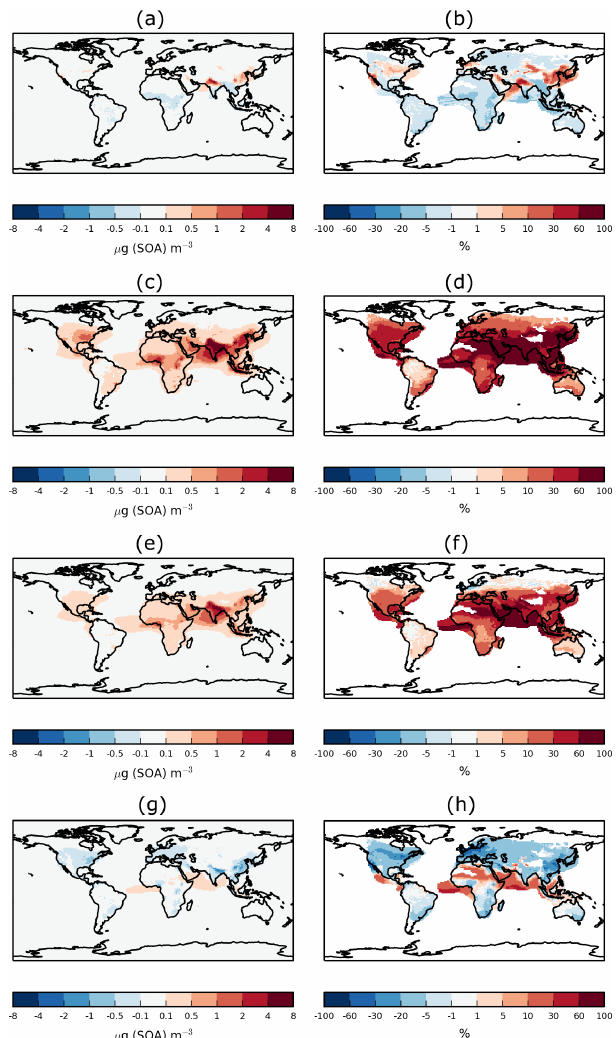
Figure 12. Difference in annual-average surface SOA concentra- tions, expressed as absolute concentrations (µgm − 3 ) (a, c, e, g) and as a percentage (b, d, f, h) between Multi_nap (top row; a, b ), Multi_nap_yield (second row; c, d ), Multi_tol_yield (third row; e, f ), and Multi_benz_yield (fourth row; g, h ) and the DryH_WetL simulation, which are all described in Table